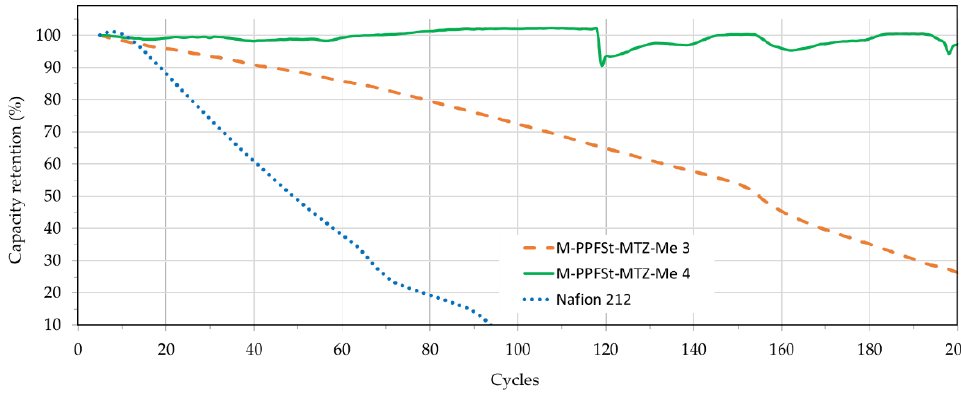
Figure 8. The charging-discharging cycling test.